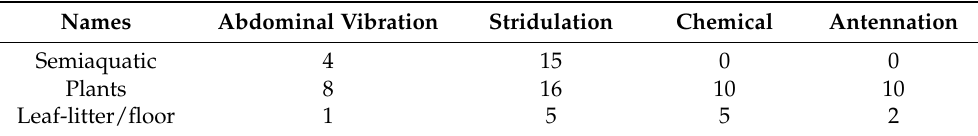
Table 1. The number of heteropteran families found in one of 3 habitats: leaf litter, plant, or semi- aquatic habitats, and use one of 4 methods of sexual communications: stridulation, abdominal vibration, chemicals or